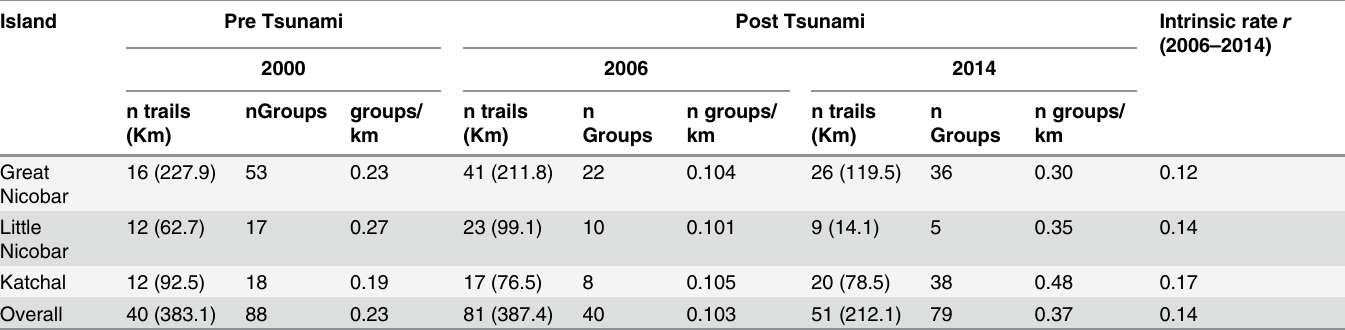
Table 6. Number of M . f . umbrosus groups encountered per kilometre during 2000, 2006 and 2014 studies in Nicobar Islands.